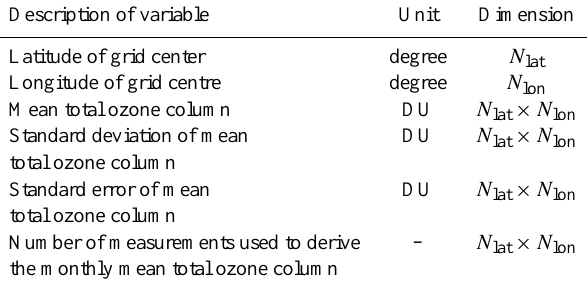
Table 3. Description and dimensions of all variables contained in the level 3 monthly mean total ozone NetCDF files. N lat = 180 and N lon =